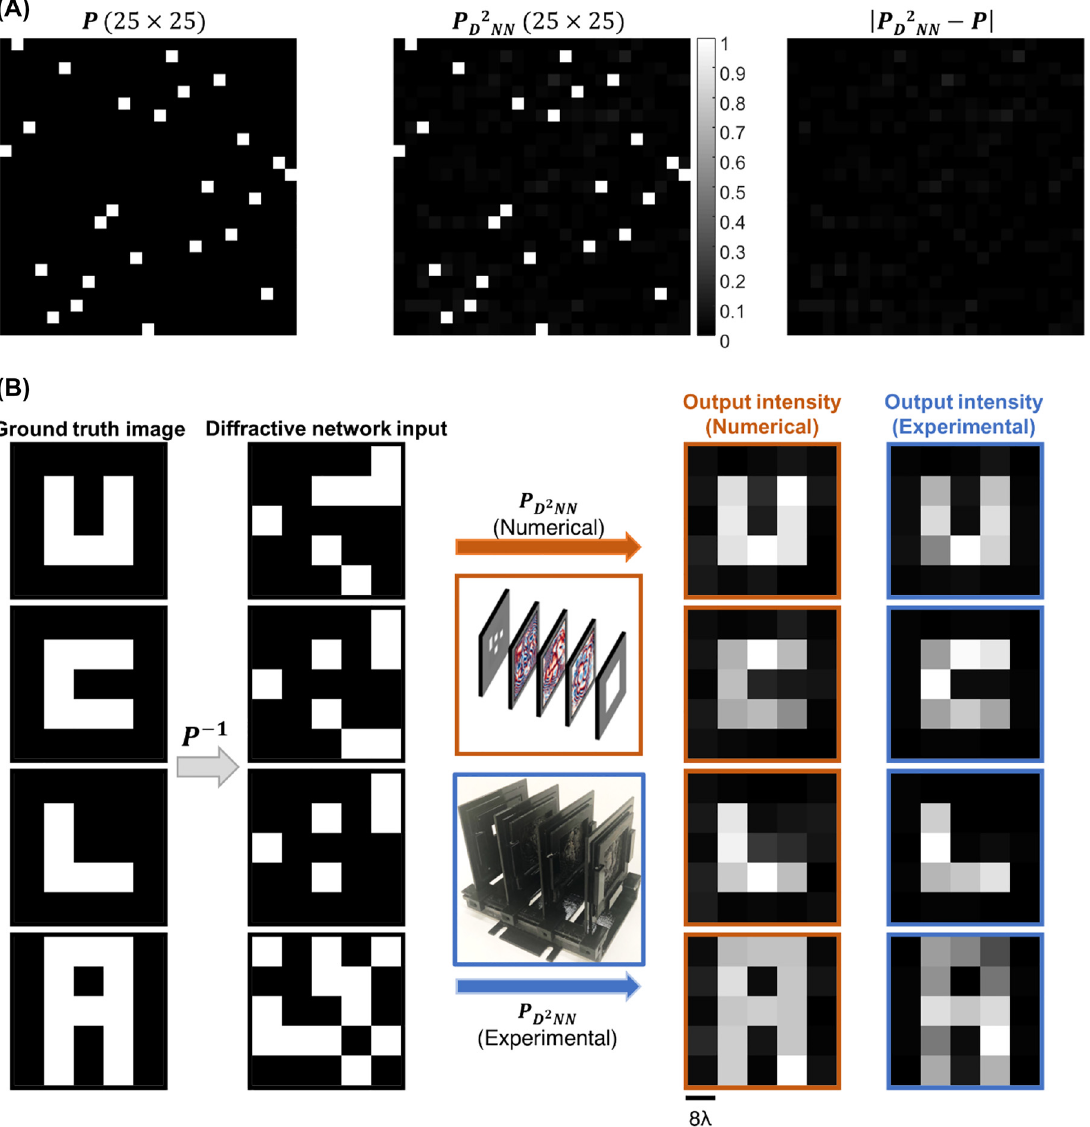
Figure 6: Experimental results. (A) (left) The desired 25 × 25 permutation matrix, P , (middle) the optically realized permutation operation predicted by the numerical forward model, P D 2 NN , and (right) the absolute error map between the two matrices. (B) Comparison between the numerically predicted and the experimentally measured output images for the task of recovering intensity patterns describing the